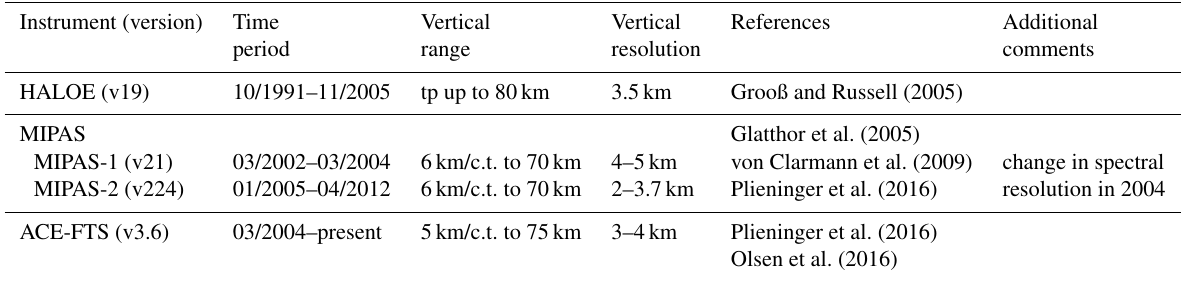
Table 11. Time period, vertical range, vertical resolution, references, and other comments for CH 4 measurements. Note that tp refers to tropopause and c.t. to cloud top in this